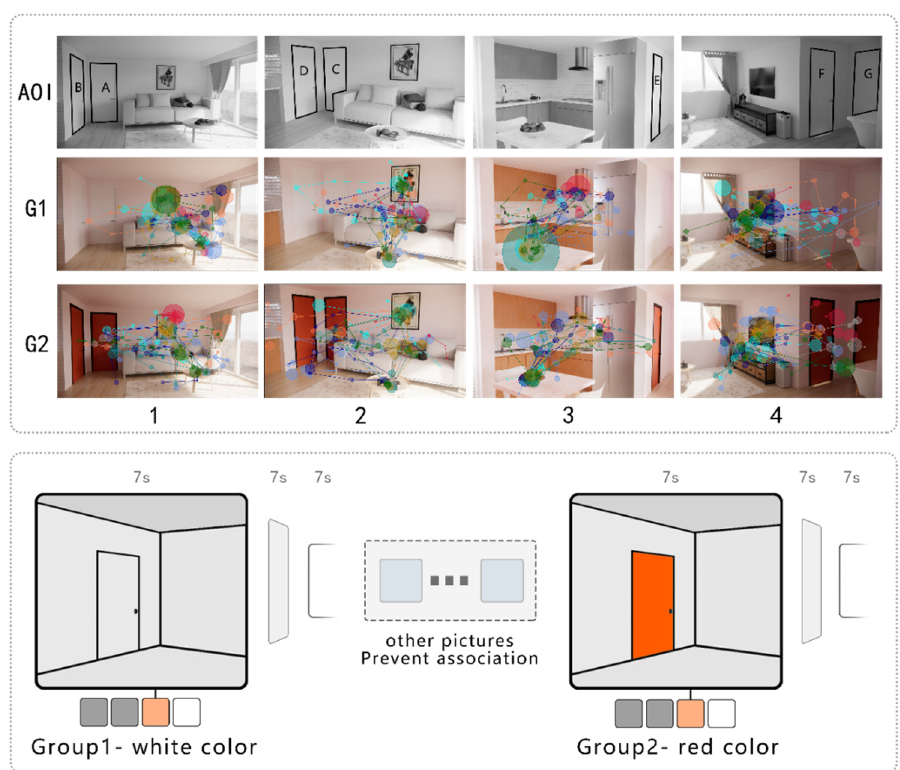
Figure 6. AOIs, stimuli scan paths, and procedure.